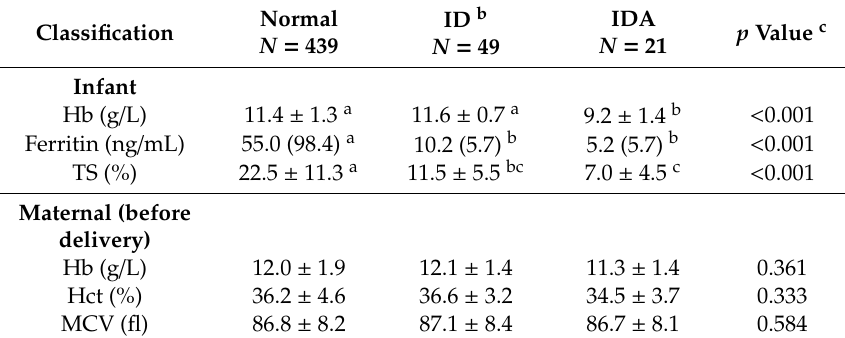
Table 2. Hematologic data of subjects a .